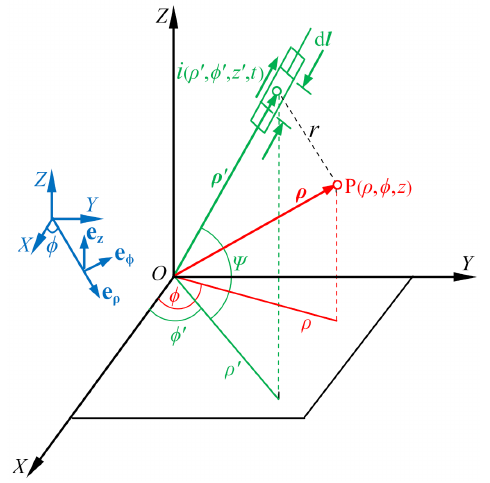
Figure 4. Tilted